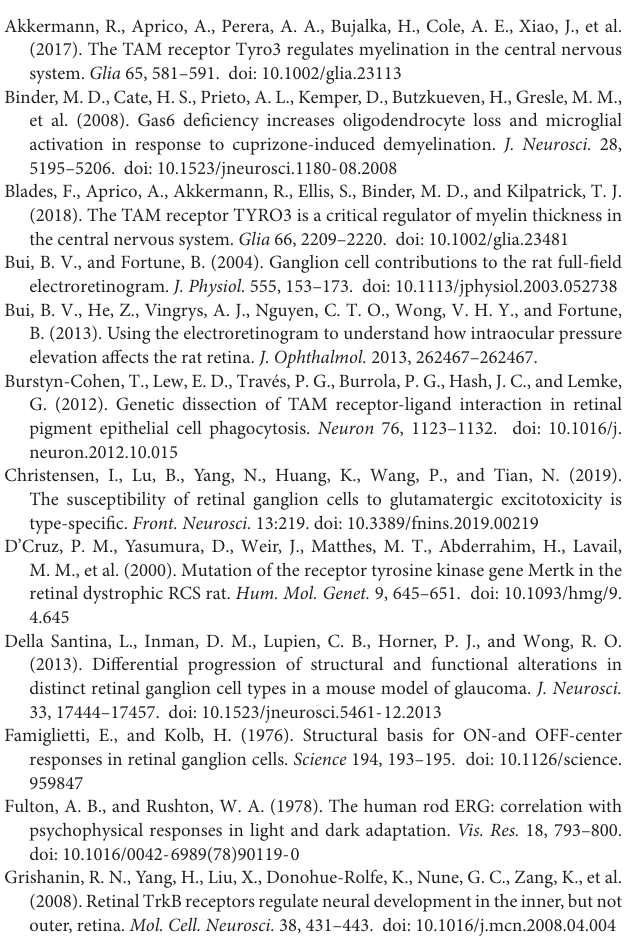
FIGURE S1 | Sensitivity and timing of electroretinogram components in Tyro3 KO and wildtype mice. Dark-adapted full-field ERGs were performed to examine retinal function in WT and Tyro3 KO mice ( n = 10/genotype), enabling sensitivity and timing of various retinal cell classes to be quantified. Tyro3 deficient mice showed no significant reductions in the photoreceptor sensitivity (A) and bipolar cell sensitivity (B) to light compared to WT mice. The peak time of the retinal GC driven positive scotopic threshold response (C) was similar to the WT group. In contrast, a small but significant decrease in response timing of the oscillatory potentials, reflecting inhibitory pathways (amacrine cells) was observed in the retina of Tyro3 KO mice compared to WT controls (D; p = 0.04). Results are presented as mean ± SEM; p -value of mean differences were calculated using a two-tailed, unpaired Student’s t -test. FIGURE S2 | The reduction in RGC function is independent of the reduction in photoreceptor function. In order to determine whether the loss of bipolar cell function and RGC function as assessed by ERG component amplitude could be attributed to the loss of photoreceptor function, we used previously determined gain relationship calculations between components in C57Bl/6 mice